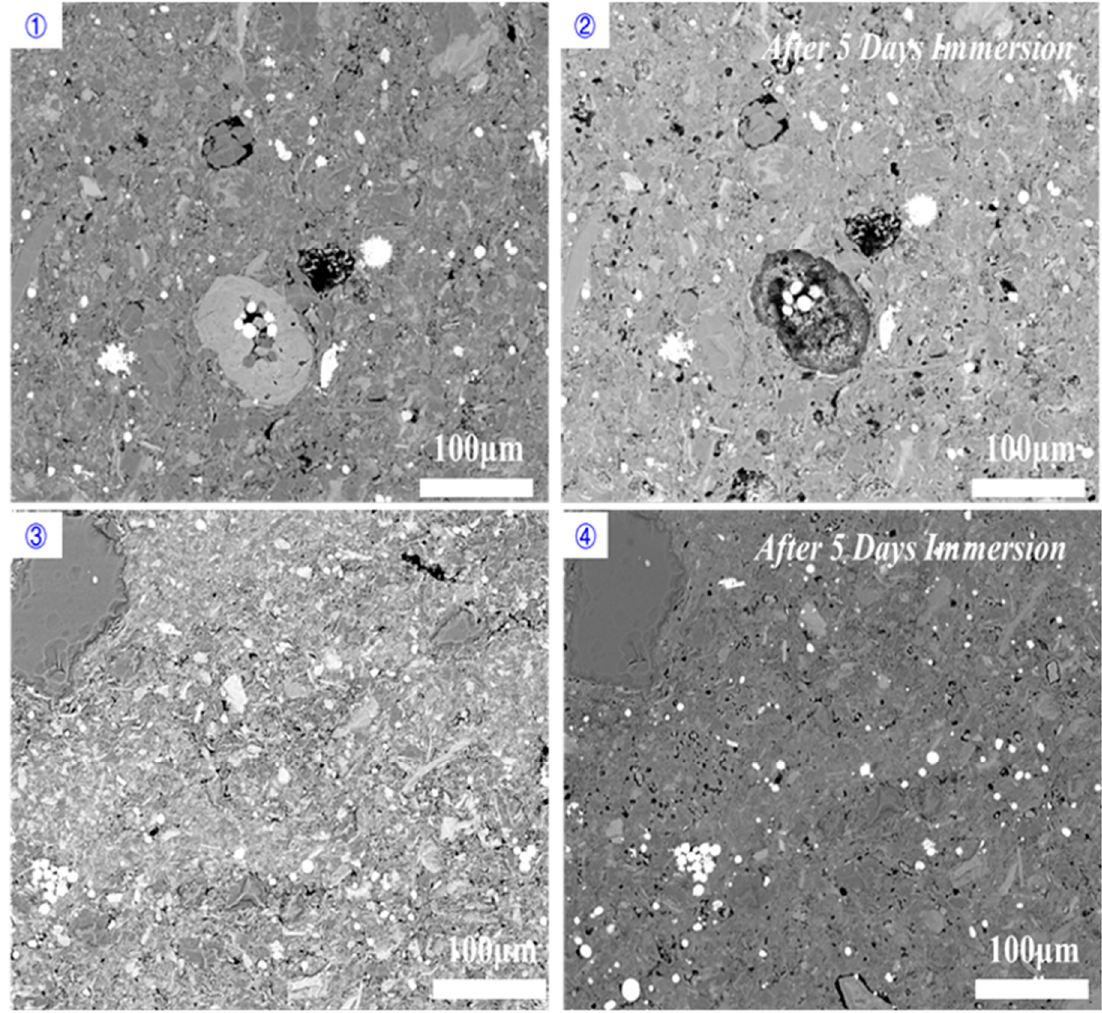
Figure 9. Shale sublayer surface variations before and after ( a ) 1 day’s, ( b ) 3 days’ and ( c ) 5 days’ saturation for the imbibition perpendicular to bedding planes.